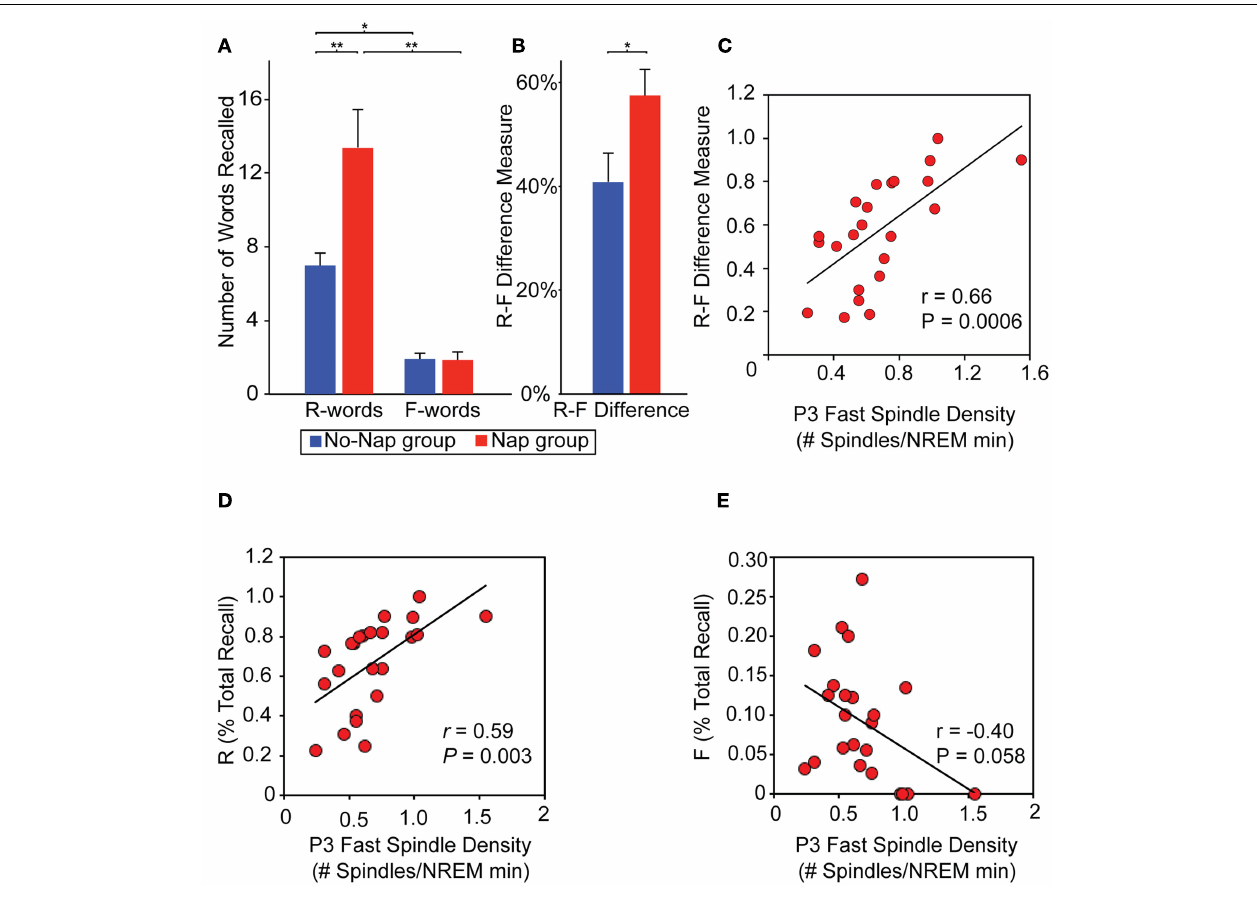
and sleep spindles: (C) Scatter-plot and linear regression of the relationship between fast sleep-spindle density at P3 and the R–F score across participants in the nap group. (C–D) Scatterplots demonstrating that the same P3 fast spindles (D) positively predict R-words and (E) negatively predict F-words, though neither correlation is as strong as the R–F difference measure, suggesting a relative selectivity of sleep-dependent memory consolidation. Modified from Saletin et al.